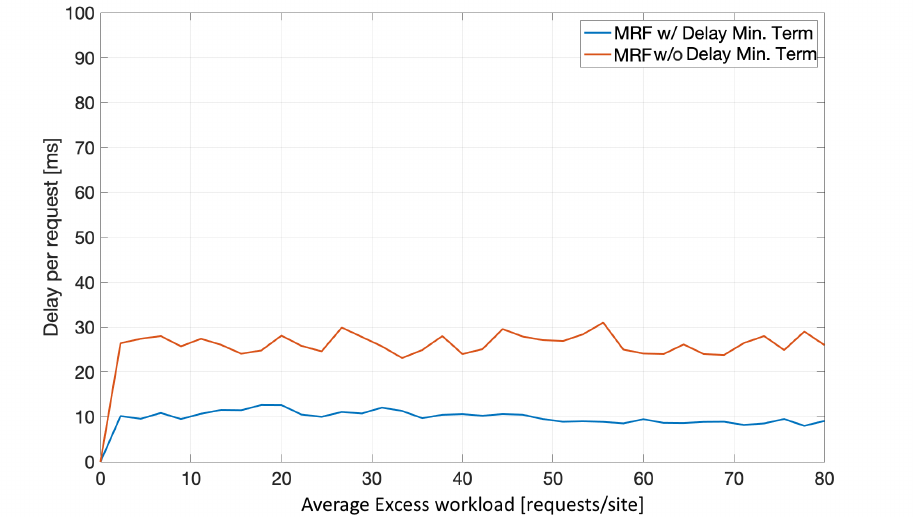
Figure 11. MRF workload redistribution-induced delay minimizing for various excess